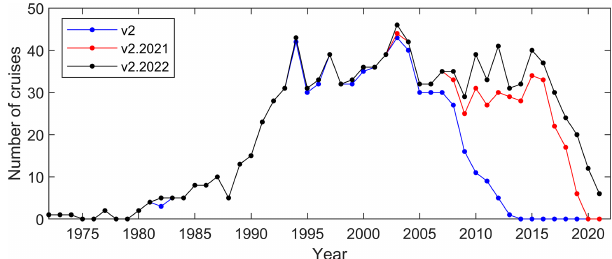
Figure 2. Number of cruises per year in GLODAPv2, GLO- DAPv2.2021, and